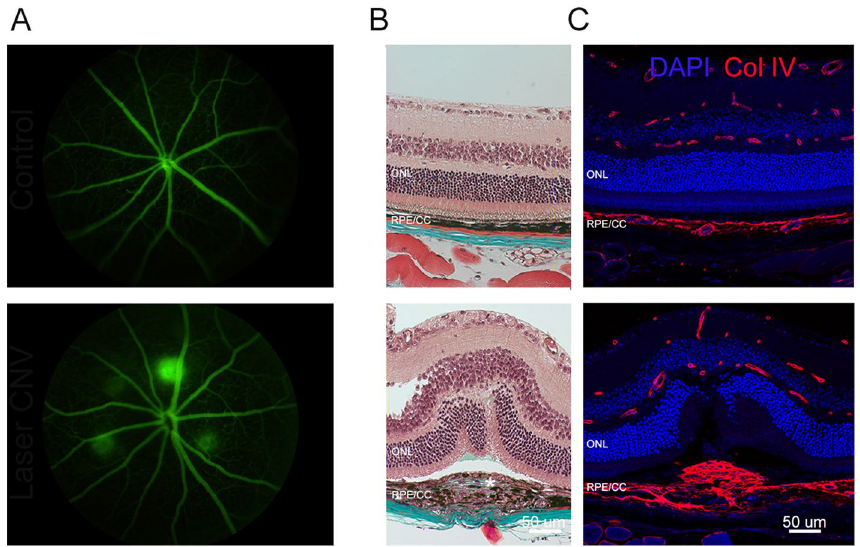
Figure 1. Fibrovascular characteristics of the laser CNV model in mice. ( A ) Fluorescein fundus images of a control eye upper panel and an eye 7 days after laser induced CNV in the lower panel. In the lower panel, there are four lesions visible around the optic nerve head. ( B ) Brightfield micrographs of vertical sections of retina stained with trichrome. The upper panel shows a control eye, collagen labelling (blue) is visible in sclera. Lower panel shows a CNV lesion with collagen visible (blue label) in sclera and within the lesion (white asterisk). ( C ) Fluorescent micrographs of vertical sections of retina stained with a nuclear stain (DAPI—blue) and collagen IV labelling (Col IV—red). The upper panel shows a control eye with collagen IV labelling within blood vessels of the retina and choroid. The lower panel shows collagen IV labelling in retina, choroid and a fibrotic mass of collagen within the CNV lesion. CNV choroidal neovascularization. Scale—50